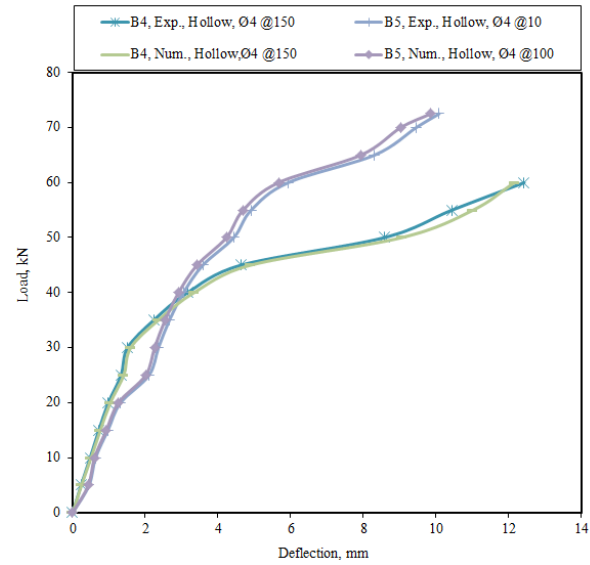
Figure 19. Experimental and numerical load versus mid-span deflection curves of the RC beams B4 and B5 (hollow rectangular).